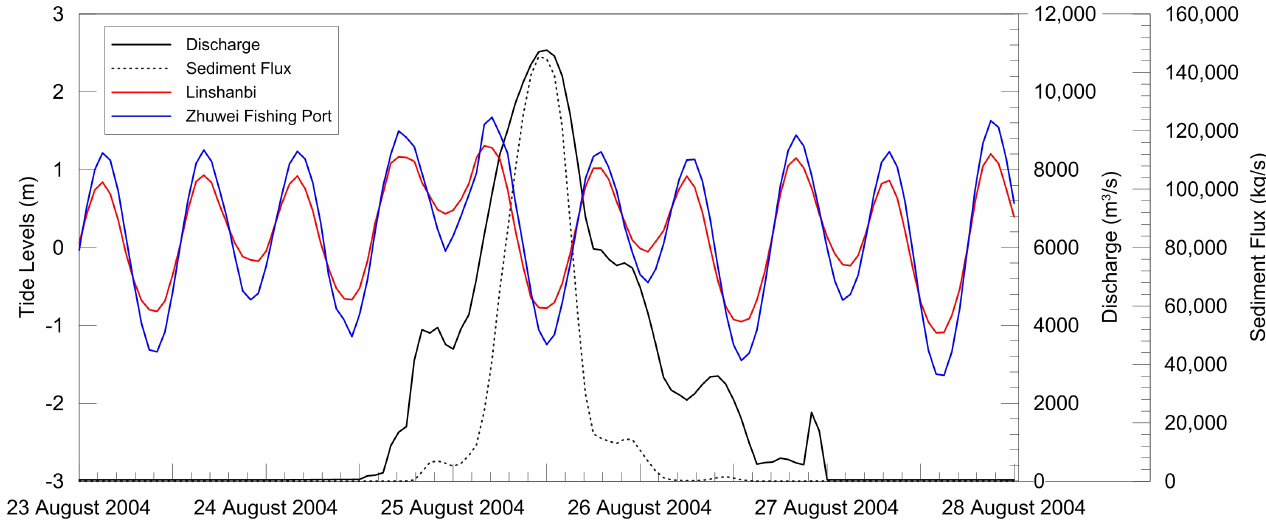
Figure 5. Upstream conditions of river discharge and sediment fluxes at the Guandu Bridge (Case 1) and tidal levels on the two cross-shore boundaries (Linshanbi and Zhuwei Fishing Port stations).